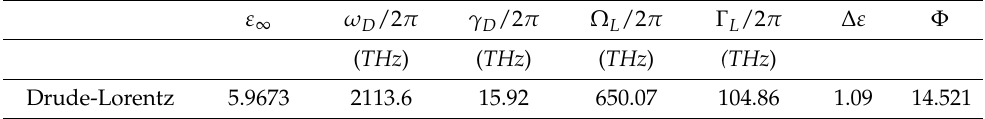
Table 1. Parameter values of the Drude–Lorentz model.